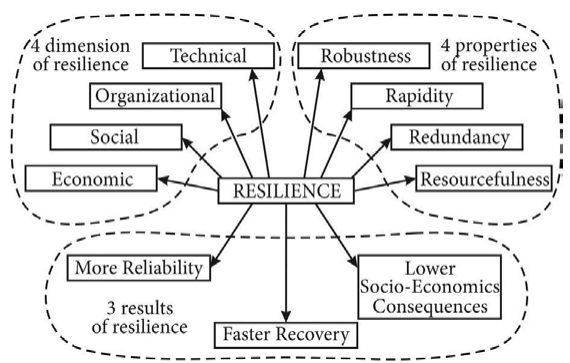
Fig. 2 . Aspects of resilience (Bruneau et al. 2003)